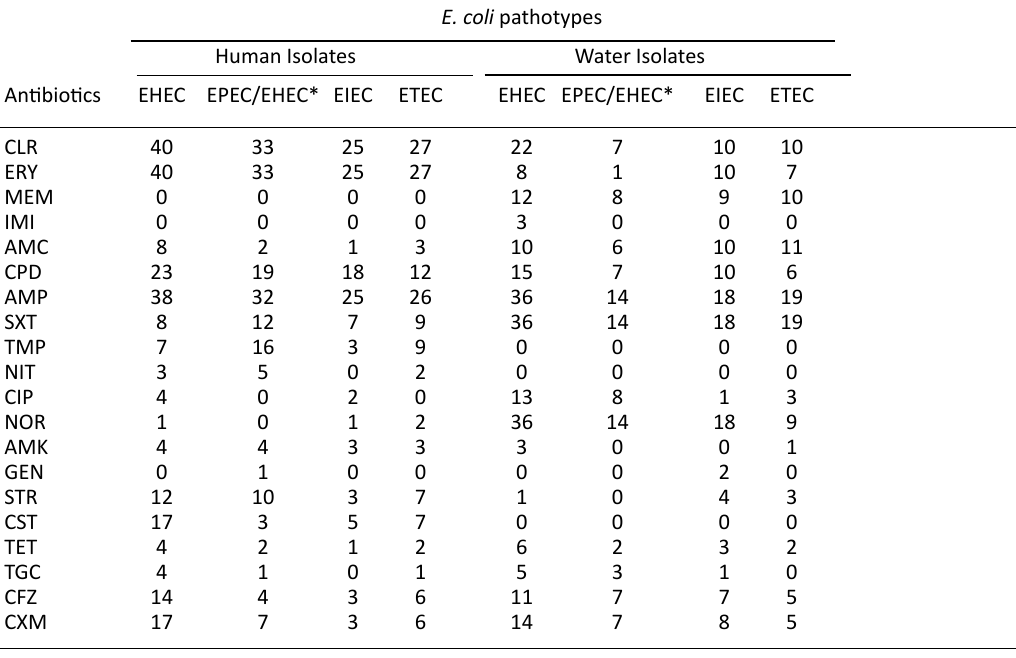
Table 5. Antibiotic resistance among E. coli pathotypes from human samples